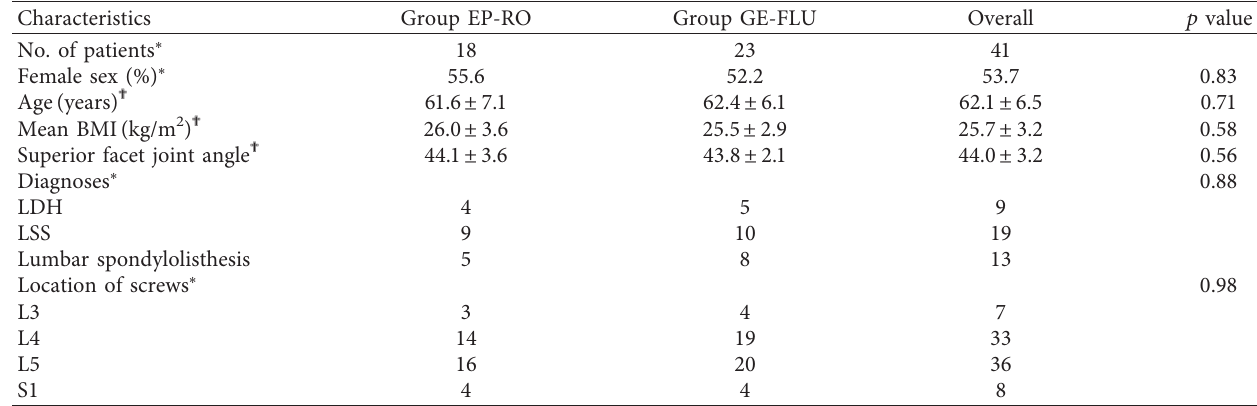
Table 2: Baseline characteristics.